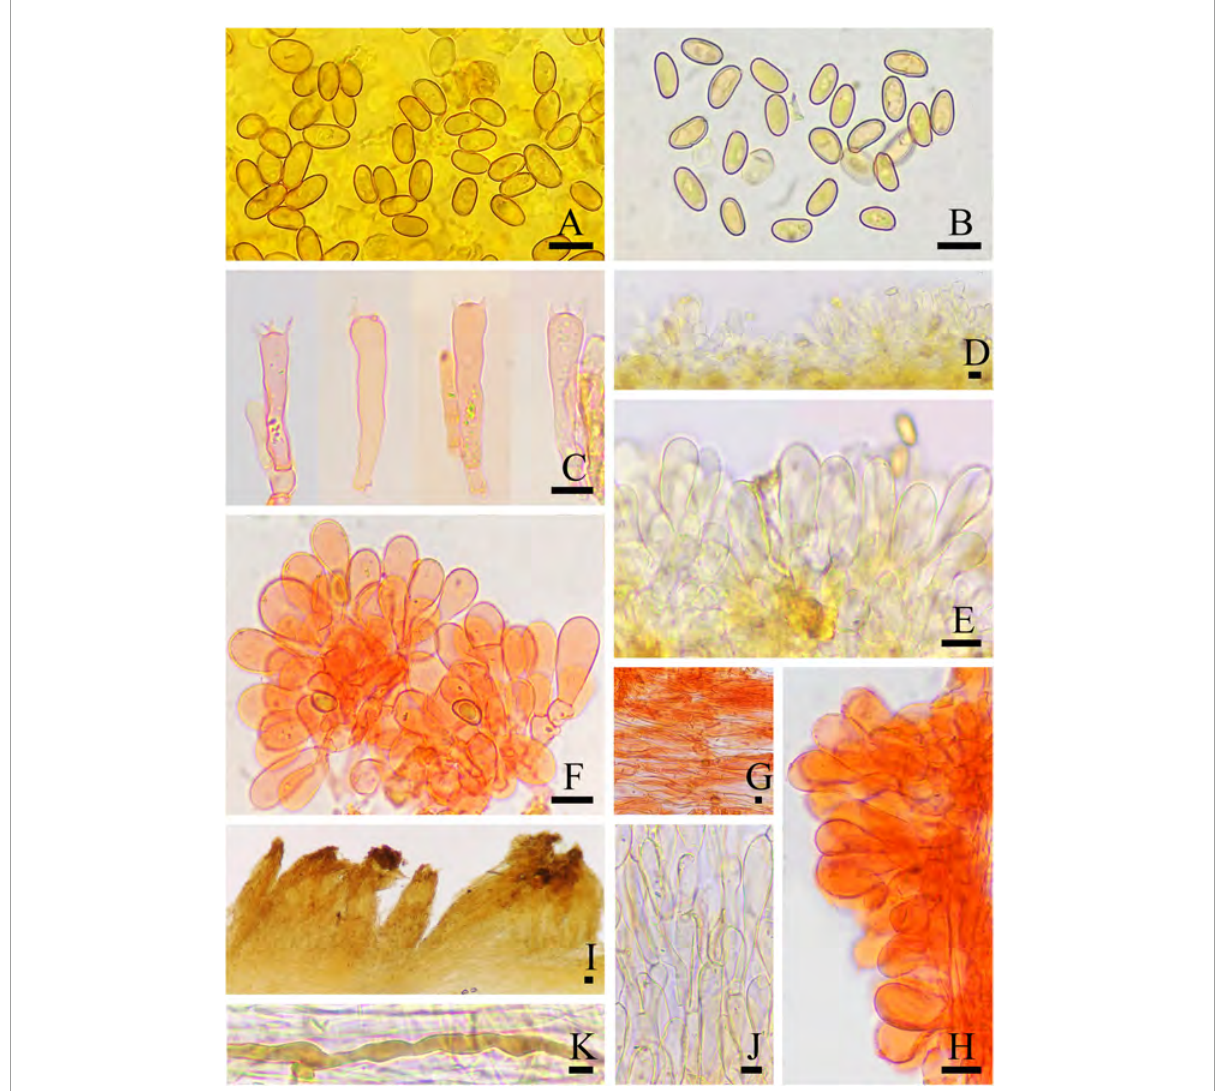
FIGURE11 Microscopic features of Inosperma squamulosohinnuleum (MHHNU32195, holotype). (A,B) Basidiospores; (C) basidia with probasidium; (D) gill edge; (E,F) cheilocystidia; (G) hymenial hyphae; (H) caulocystidia; (I,J) pileipellis; and (K) oleiferous hyphae. Scale bars = 10 µ m.